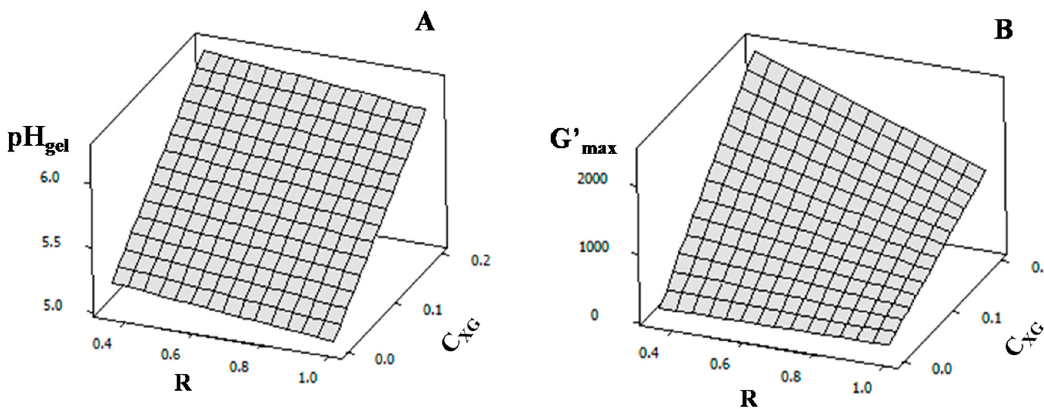
Figure 5. Response surface plots: ( A ) pH gel as a function of GDL mass fraction/NaCAS mass fraction ratio (R) and xathan gum concentration (C XG : wt %) and ( B ) G’ max (Pa) as a function of R and xathan gum concentration (C XG : wt %).